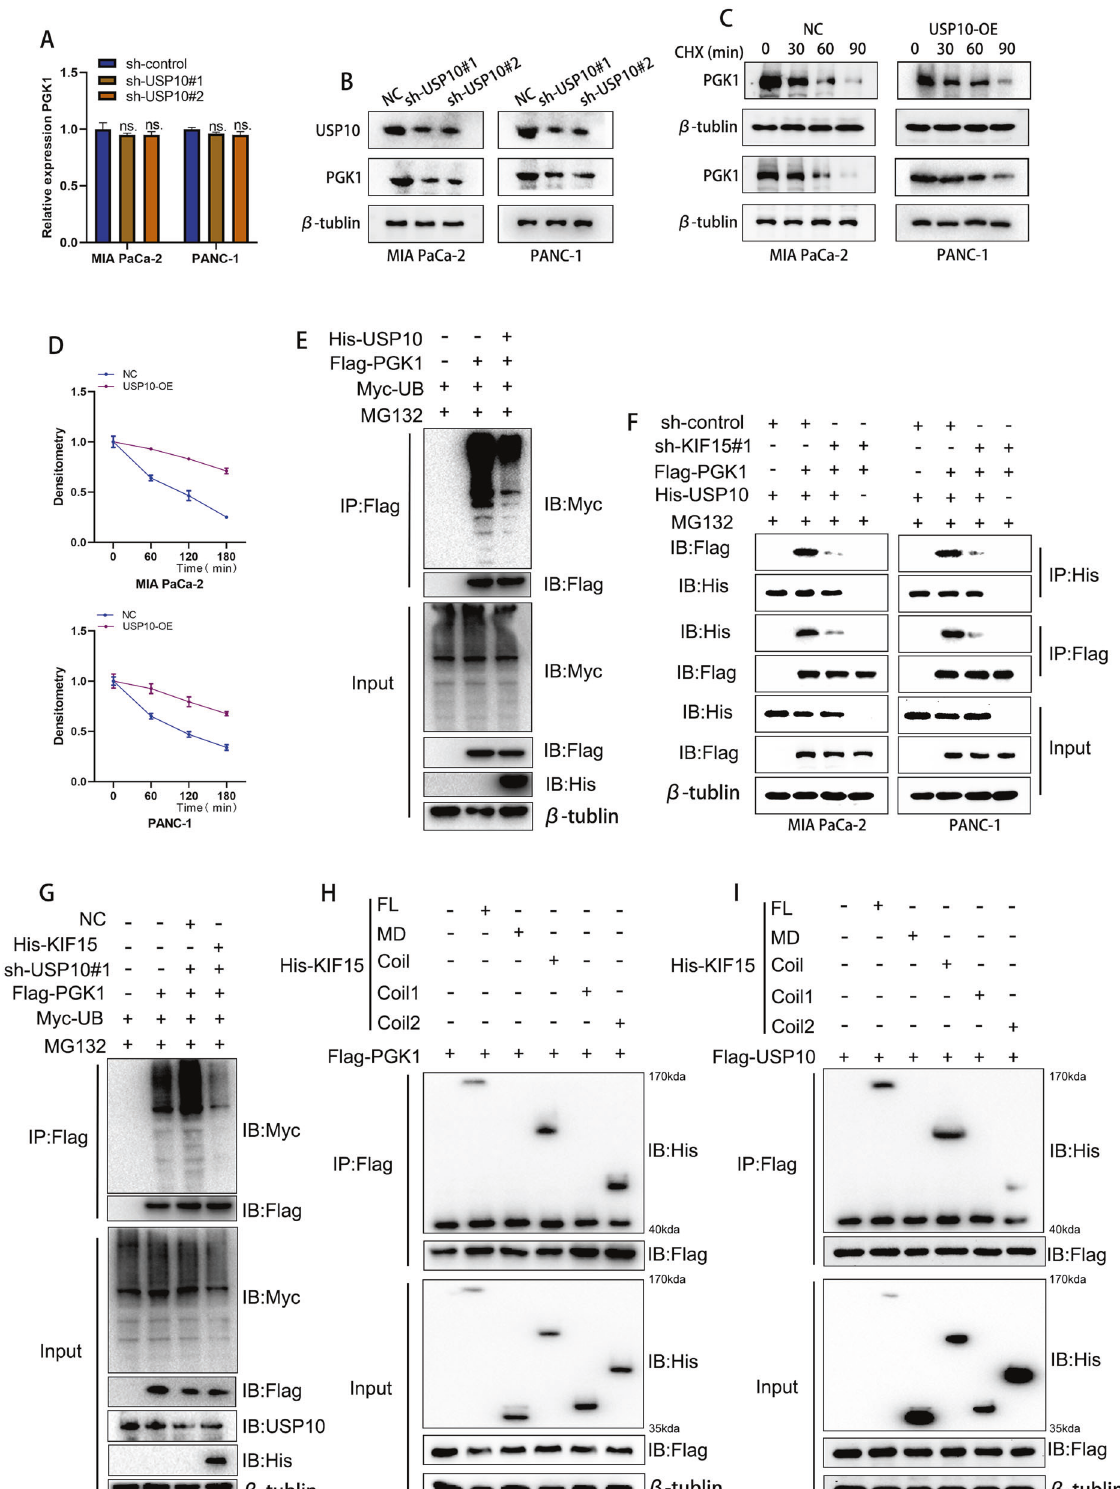
Fig. 6 KIF15 recruited USP10 to mediate the deubiquitination of PGK1. A The alteration of PGK1 mRNA after the knockdown of USP10. B The western blot assay showed the protein alteration of PGK1 after the knockdown of USP10. C The half-life of PGK1 protein was tested by western blot after the PC cells treated with CHX. D The quanti fi cation of PGK1 degradation in PC cells. E The ubiquitination level of PGK1 measured by western blot assay. F The co ‐ immunoprecipitation assay between PGK1 and USP10. G The ubiquitination level of PGK1 measured by western blot assay. H , I After construction of indicated KIF15 truncation, the western blot assay showed the exact binding domain of KIF15 responsible for the binding of USP10 and PGK1.